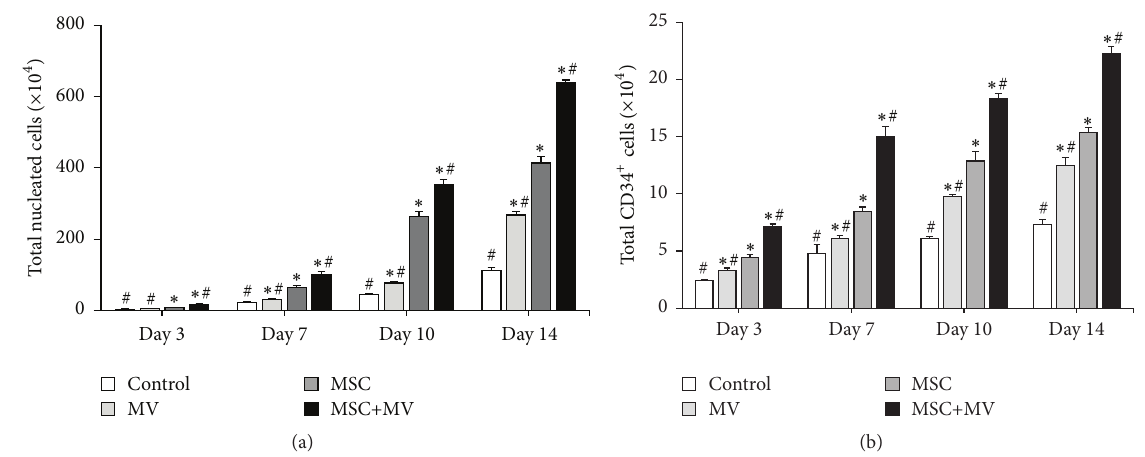
Figure 4: Ex vivo expansion of CD34 + -selected cells. CD34 + -selected cells were maintained under four different culture conditions: control, MV, MSC, and MSC+MV. (a) Growth profile of TNCs ( 𝑛 = 3 ), ∗ 𝑃 < 0.05 compared with the control group, # 𝑃 < 0.05 compared with the MSC group. (b) Growth profile of CD34 + cells ( 𝑛 = 3 ), ∗ 𝑃 < 0.05 compared with the control group, # 𝑃 < 0.05 compared with the MSC